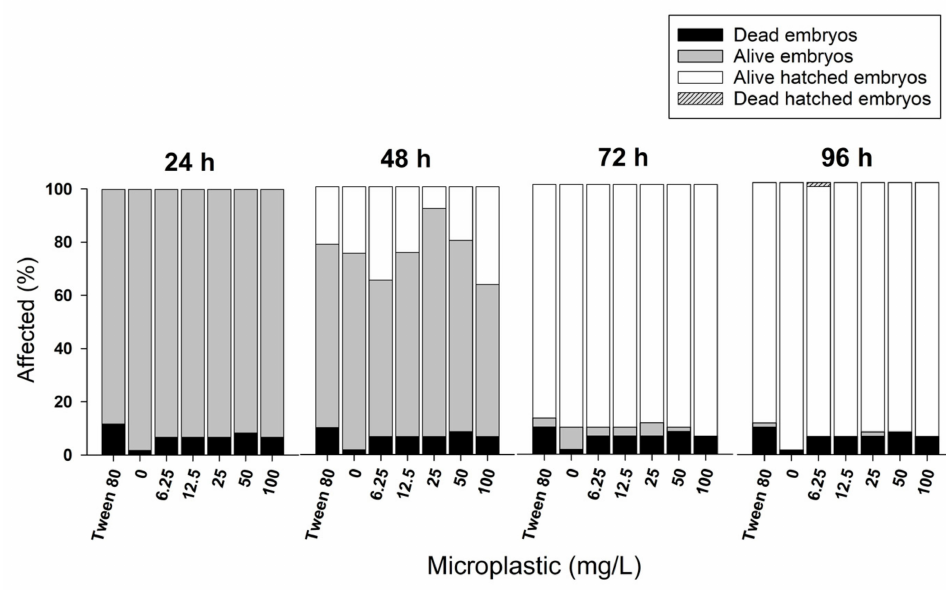
Figure 2. Results of the embryo toxicity test after 96 h of exposure, showing no alterations in the analyzed parameters compared with controls (ANOVA, p > 0.05).